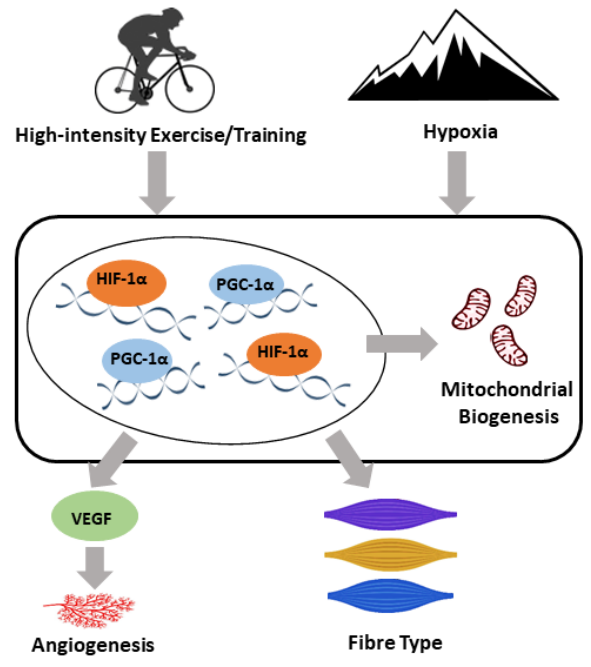
Figure 1. A speculative model for the molecular adaptive responses of skeletal muscle to both high-intensity exercise / training and hypoxia. Both exercise / training and hypoxia induce a range of adaptations, including an upregulation in angiogenesis and mitochondrial biogenesis and a shift in the skeletal muscle fibre type. Peroxisome proliferator activated receptor gamma coactivator 1 alpha (PGC-1 α ), hypoxia-inducible factor 1-alpha (HIF-1 α ), and vascular endothelial growth factor (VEGF) play important roles in the regulation of the adaptive response to both high-intensity exercise / training and hypoxia within skeletal muscle.